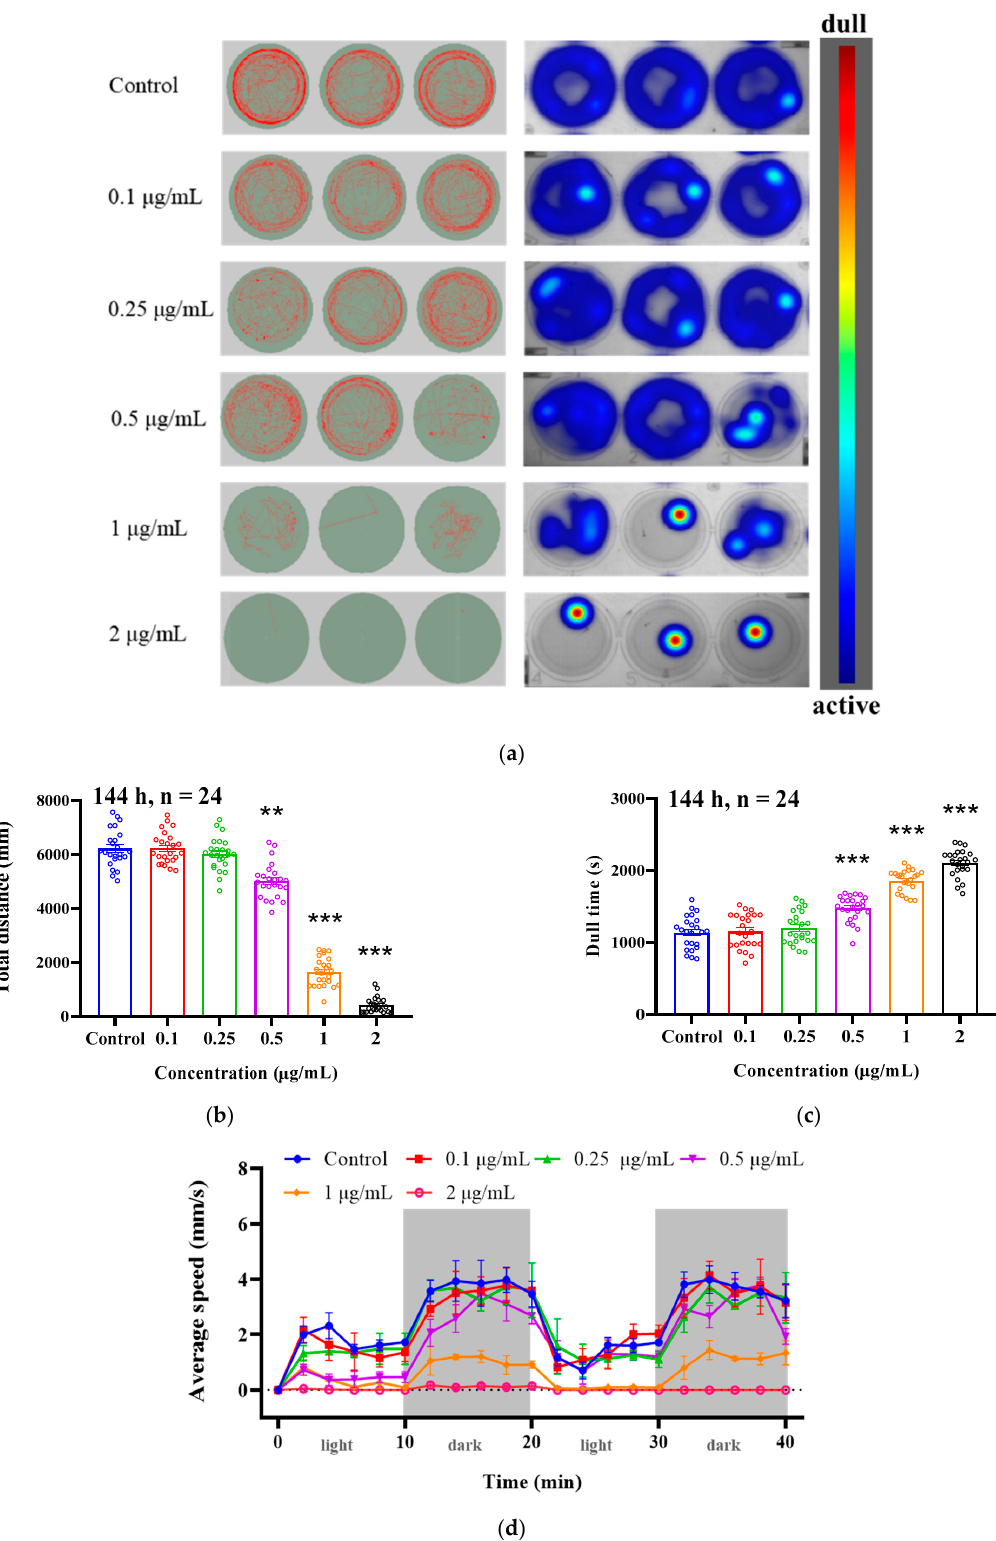
Figure 2. Altered locomotor behavior induced by exposure to EMB. Representative motion trajectories and heatmaps of motion trajectories ( a ), total distance of movement ( b ), dwell time ( c ) and mean velocity under bright- and dark-field stimulation ( d ). ( n = 24 in each group) ** p < 0.01, *** p < 0.001, compared to the control